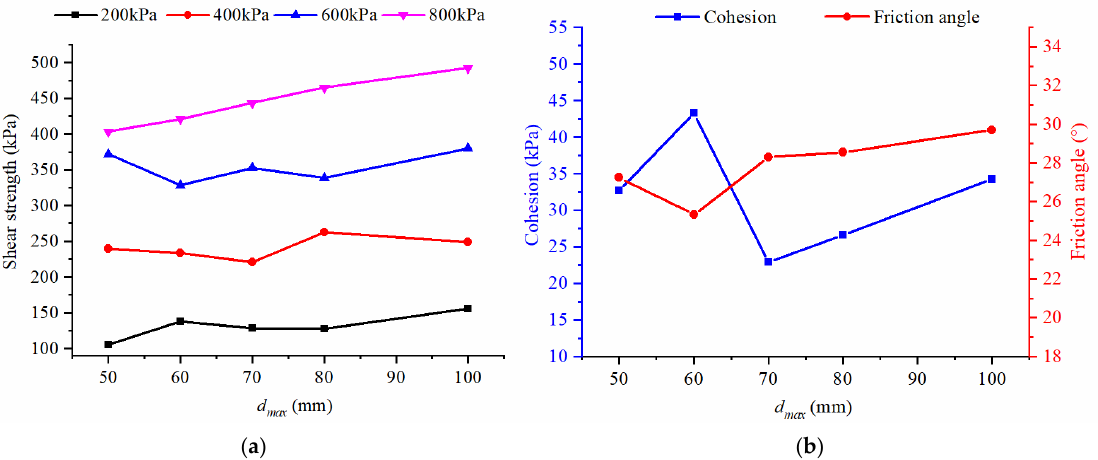
Figure 11. Relationship between the shear strength and the maximum particle size of SRM samples. ( a ) Peak shear stress; ( b ) Strength parameters.